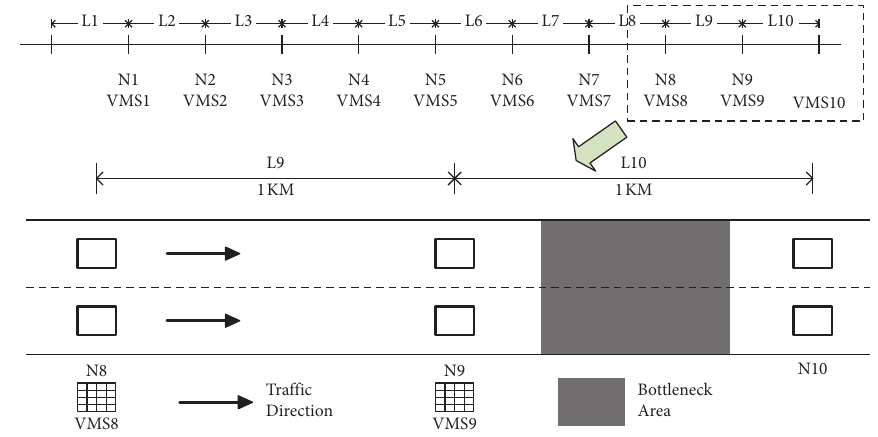
Figure 3: The simulation roadway with the Table 1: Parameter settings of simulation experiments.